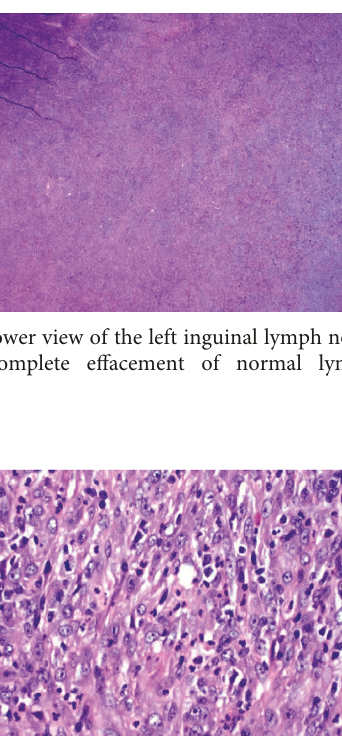
Figure 6: Inguinal lymph node CD163+